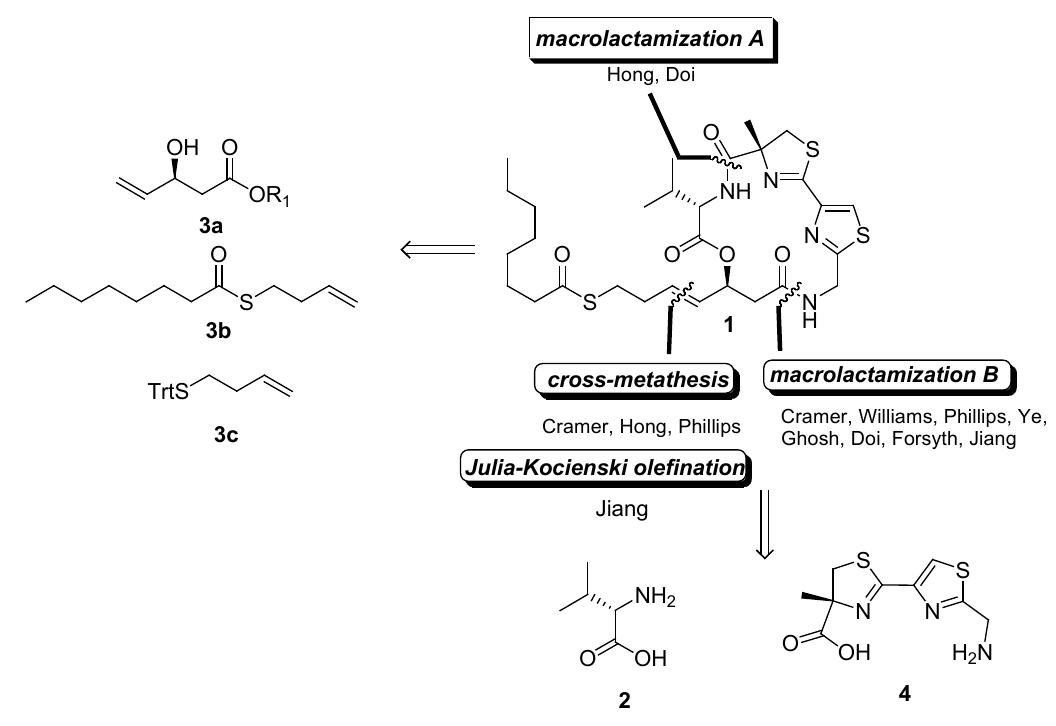
Figure 1. Synthesis strategies and key building